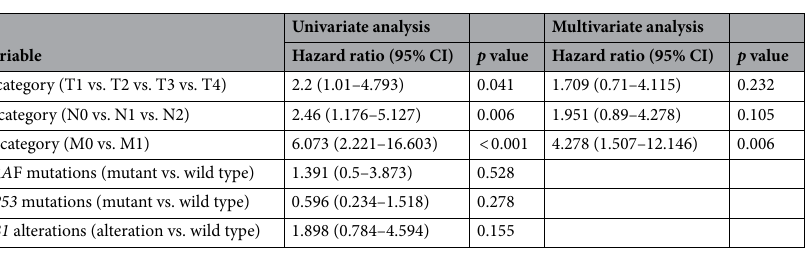
Table 3. Univariate and multivariate analysis for overall survival. CI confidence